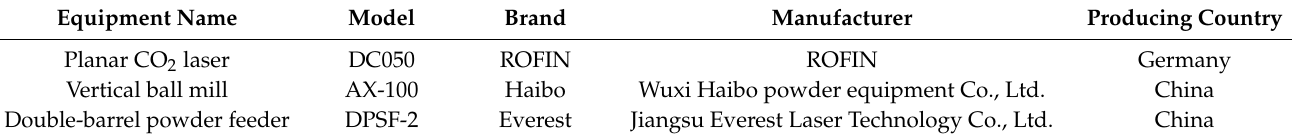
Table 2. The experimental